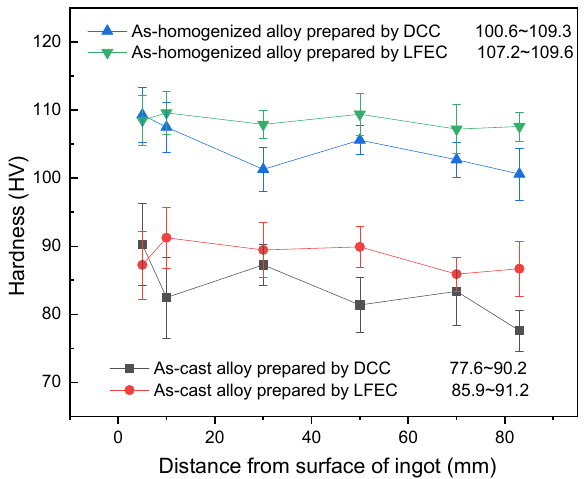
Figure 5. Hardness distribution of 5A90 alloy ingots along radial direction.